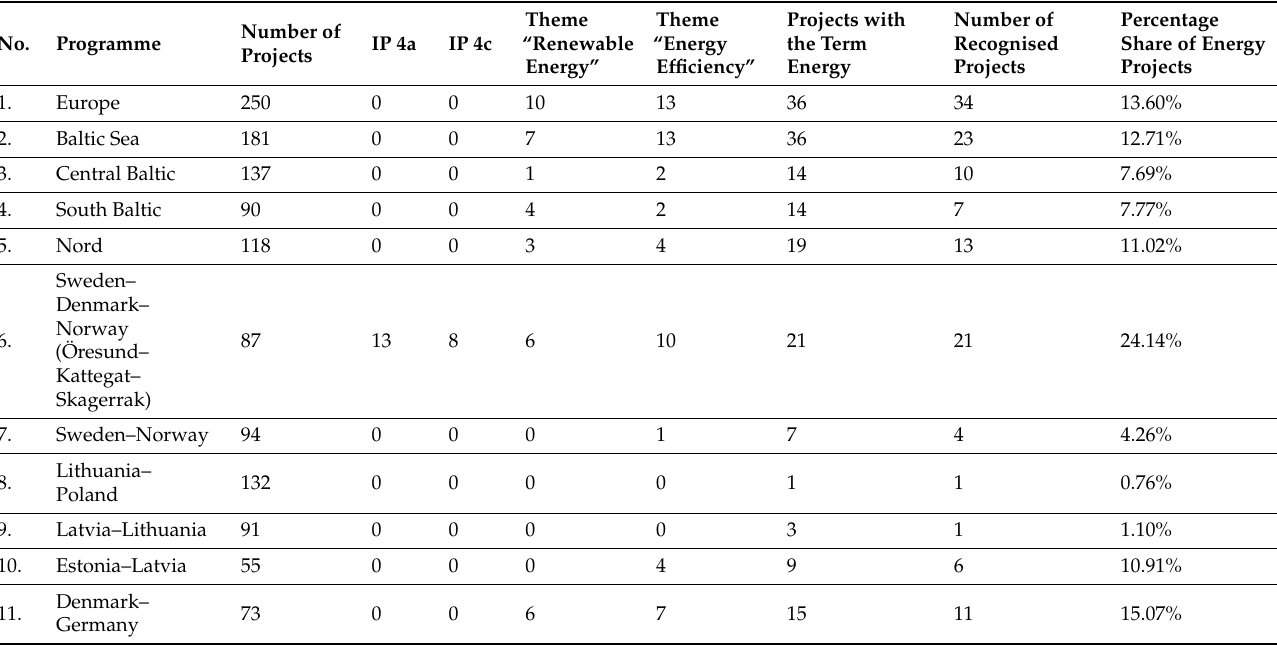
Table 4. Energy in ETC programmes for BSR in the period